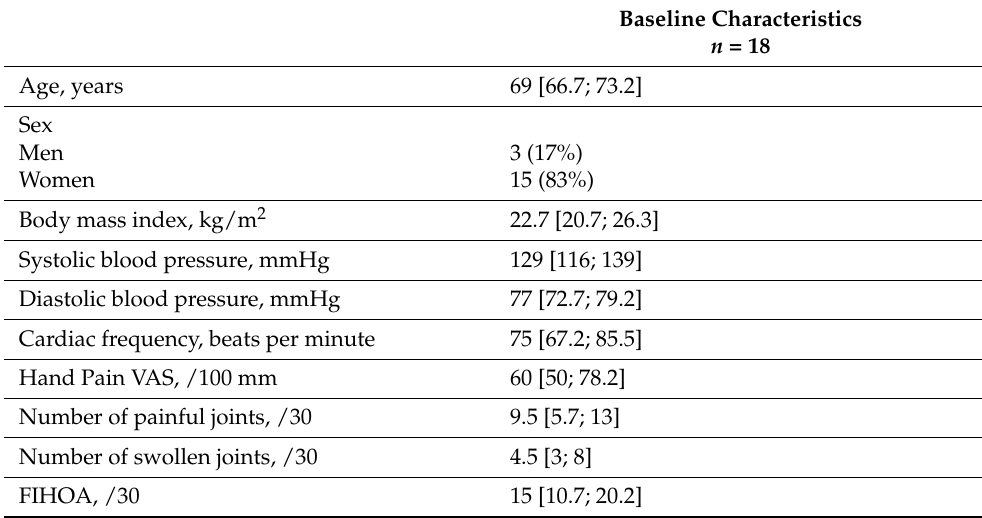
Table 1. Baseline characteristics of the patients included and analyzed. Abbreviations: FIHOA, Functional Index for Hand